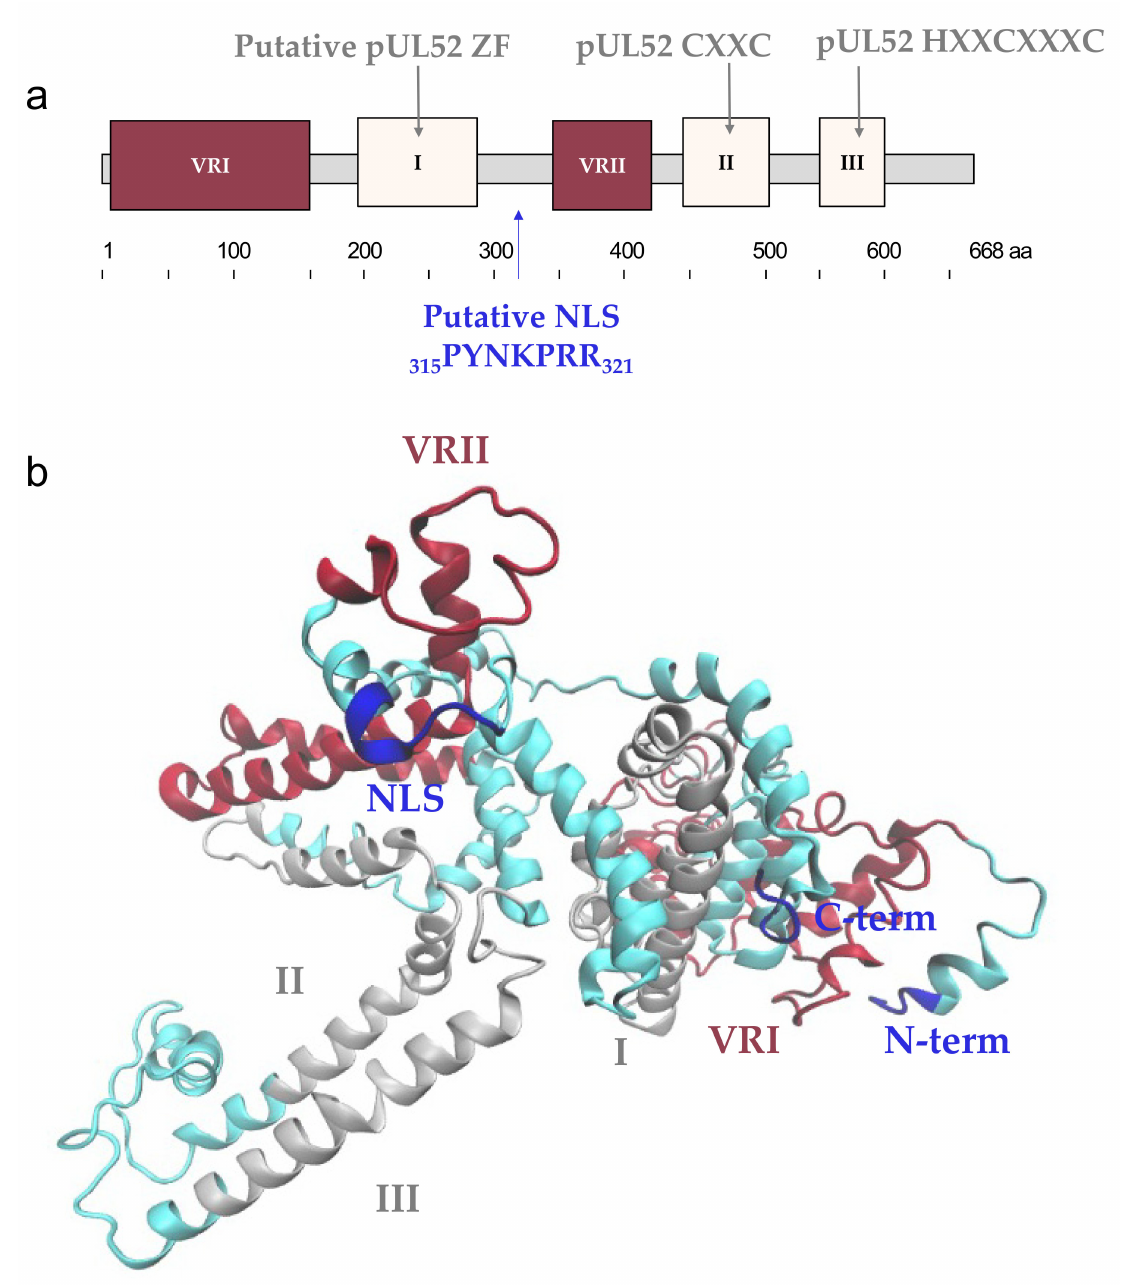
Figure 6. Structure of pUL52. ( a ) Structure of HCMV pUL52 with conserved and variable regions. The putative zinc-finger (ZF), CXXC and HXXCXXXC patterns are in the conserved regions I, II, III, respectively. ( b ) Predictive atomic structure of pUL52. The amino acid sequence of pUL52 HCMV (DAA00157.1) was submitted in I-TASSER (Iterative Template fragment Assembly Simulations), and the final model with the higher confidence score (c-score) was analyzed using VMD 1.9.4 (Visual Molecular Dynamics). Variable and conserved regions determined by polymorphism and sequence alignment analysis are represented in saddle brown and grey, respectively. The putative NLS 315 PYNKPRR 321 , N-term and C-term are represented in blue. VRI and VRII: variable regions I and II. aa: amino